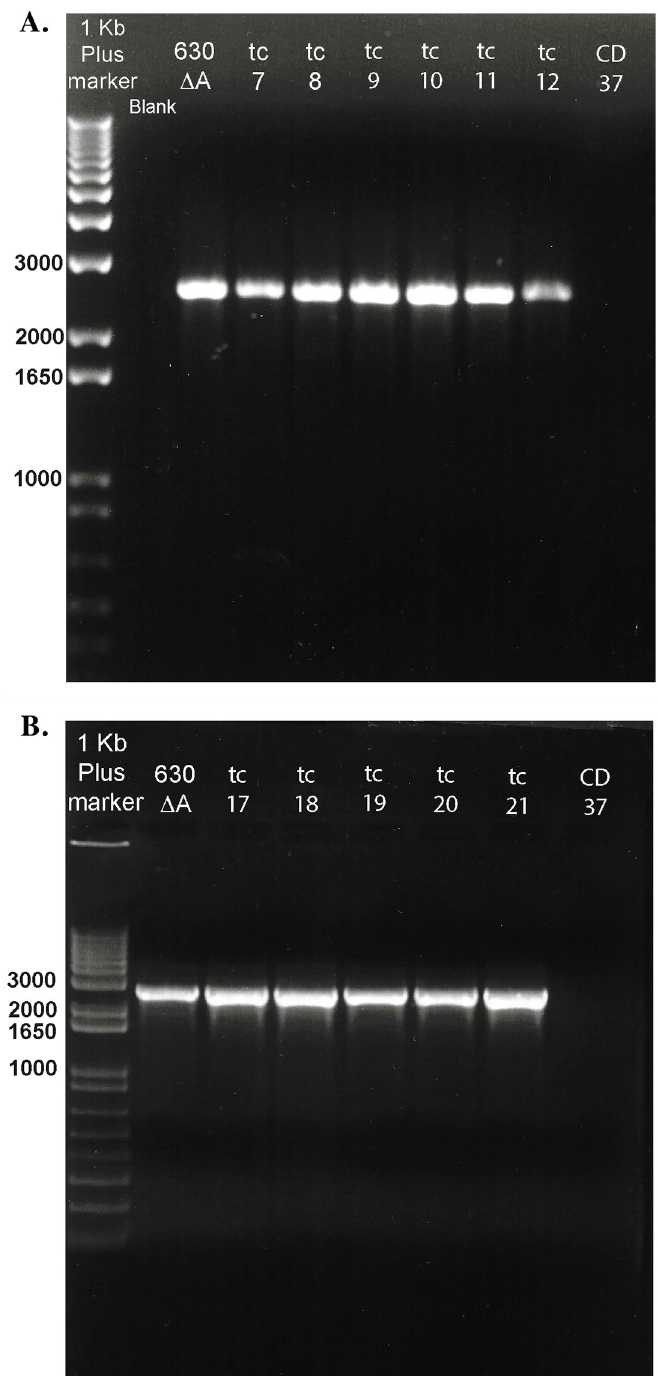
Fig 2. PCR amplification of 3’ tcd B sequences in 11 CD37 transconjugants and donor strain 630 Δ tcd A. A . Lane 1; 1Kb Plus DNA ladder with the donor strain 630 Δ A in the next lane followed by transconjugants tc7- tc12 and TC37. B . Lane 1; 1Kb Plus DNA ladder with the donor strain 630 Δ A in the next lane followed by transconjugants tc17-21 and CD37. All transconjugants show amplicons of the expected 2600bp size found in 630 Δ A. The far right lanes in both gels show the negative results for recipient parent strain CD37.